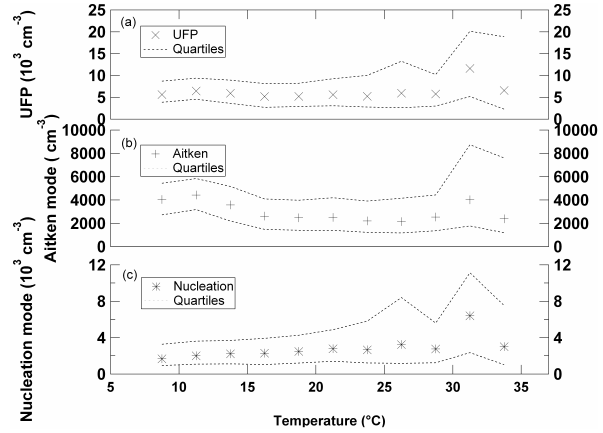
Fig. 4. Particle number concentrations of (a) ultrafine (UFP), (b) Aitken mode and (c) nucleation mode particles and their varia- tion as a function of temperature. The median number concentra- tions and the 1st and 3rd quartiles are presented.